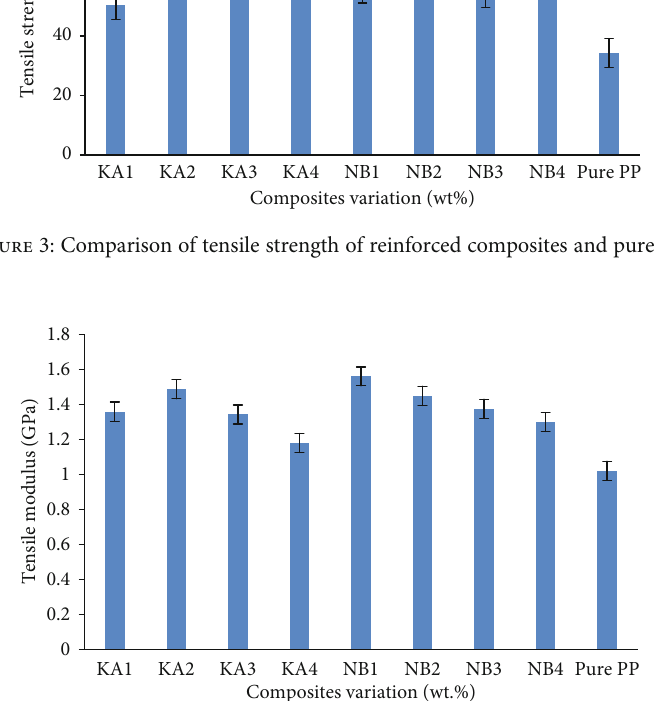
Figure 4: Comparison of tensile modulus reinforced composites and pure